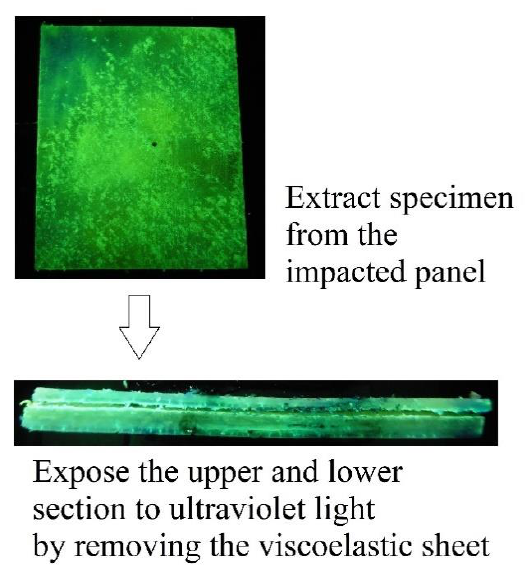
Figure 6. Test evaluation procedure for fluorescent penetrating inks.